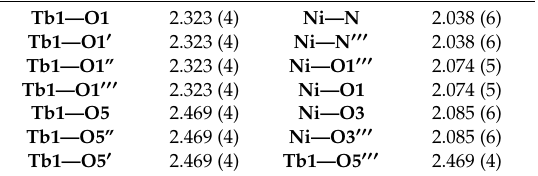
Table 1. Selected bond distances (Å) in 4 · 4EtOH · 4H 2 O.